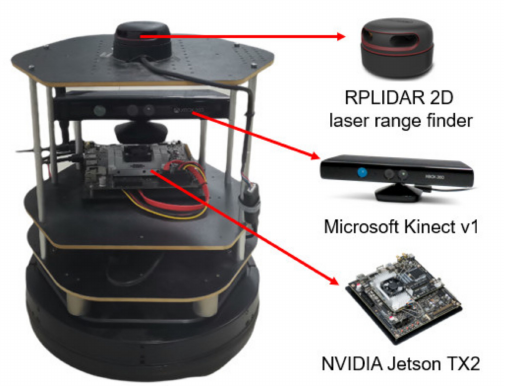
Figure 10. A turtlebot2 used for experiments in real-world